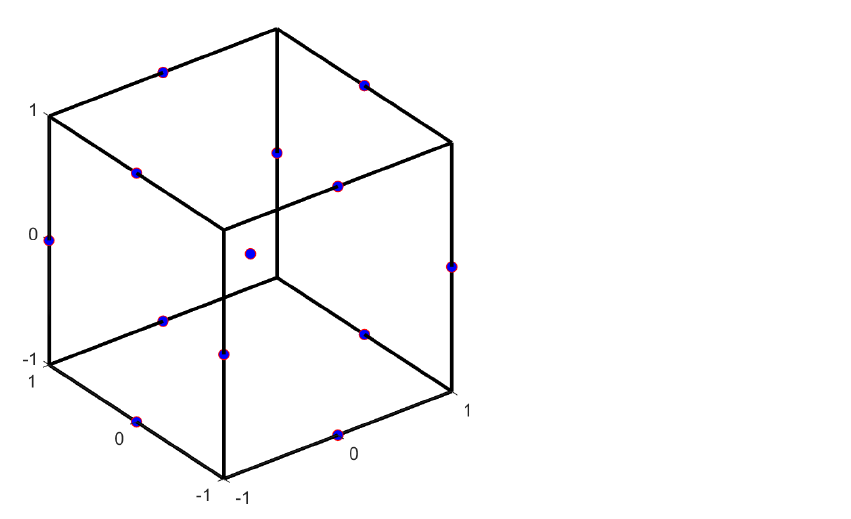
Figure 2. Box–Behnken design represented for a 3-dimensional variable space.